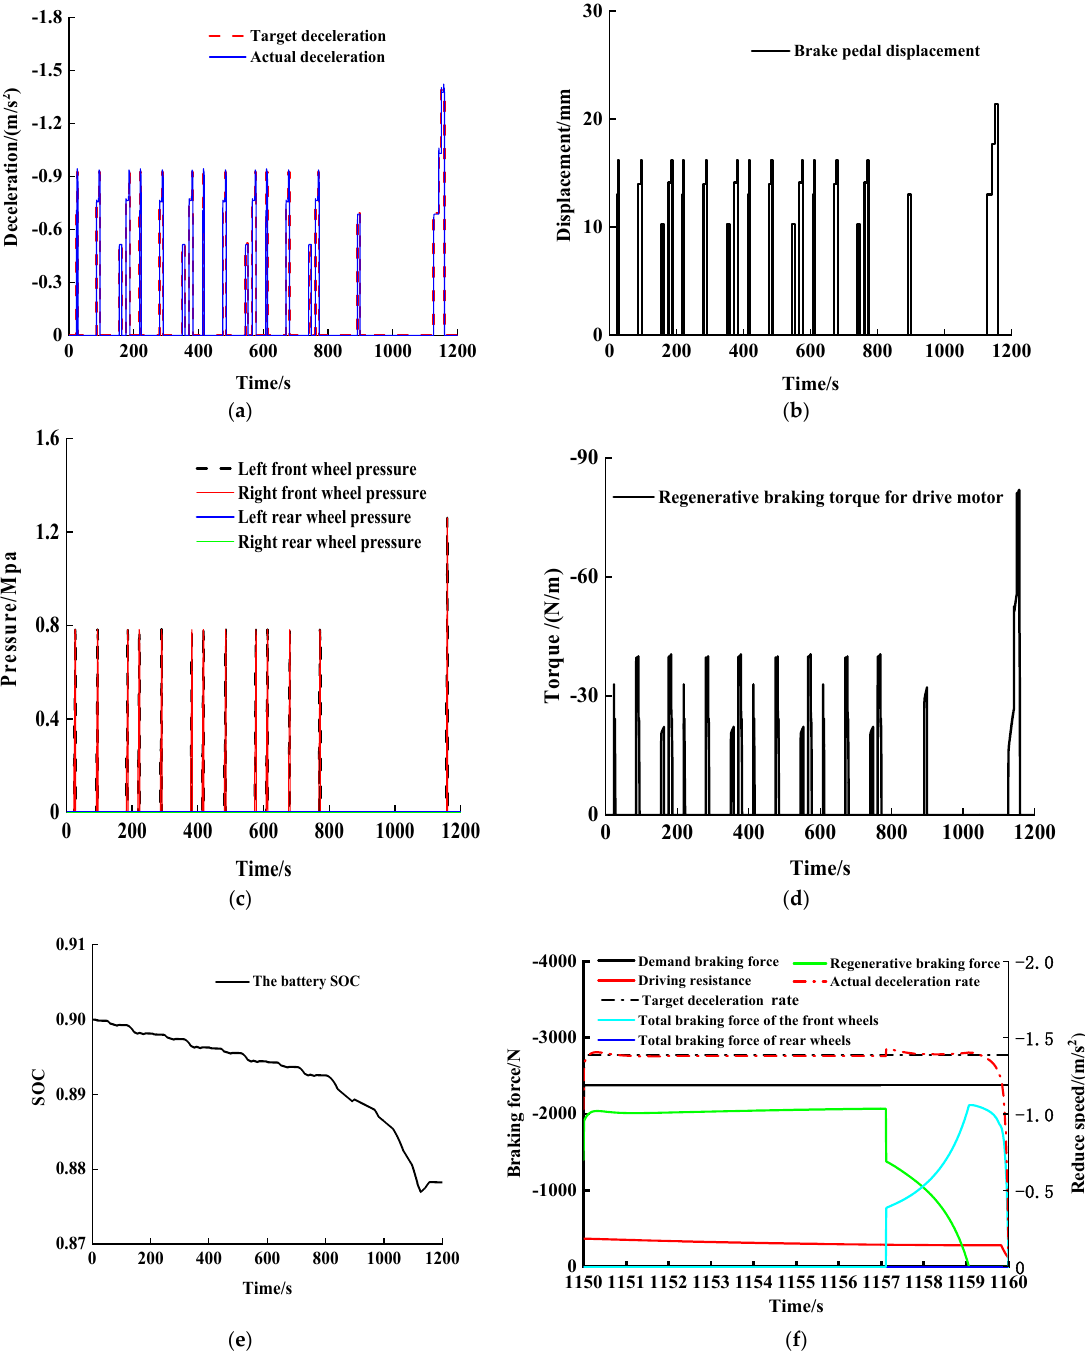
Figure 8. The simulation results of high adhesion NEDC cycle conditions. ( a ) Brake deceleration. ( b ) Brake pedal displacement. ( c ) Brake pressure. ( d ) Regenerative braking torque for drive motor. ( e ) The battery SOC. ( f ) Braking force distribution in 1150~1160 s.